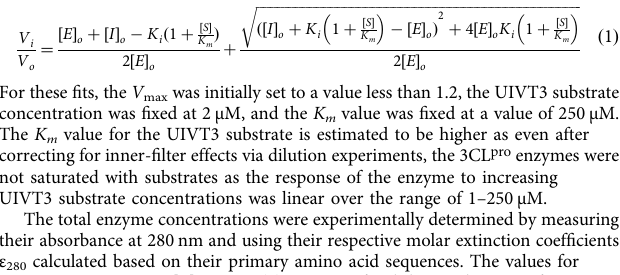
Fig. S3 have been published. Expression and puri fi cation protocols for 3CL pro from NL63, OC43, HKU9 and IBV coronaviruses were performed as described 47 with the following modi fi cations. NL63 3CL pro was expressed and puri fi ed using a modi fi ed protocol based on the puri fi cation of murine hepatitis virus (MHV) 3CL pro using a DEAE-Cellulose column. OC43 and HKU9 3CL pro were expressed using the autoinduction protocols developed for MERS 3CL pro followed by the